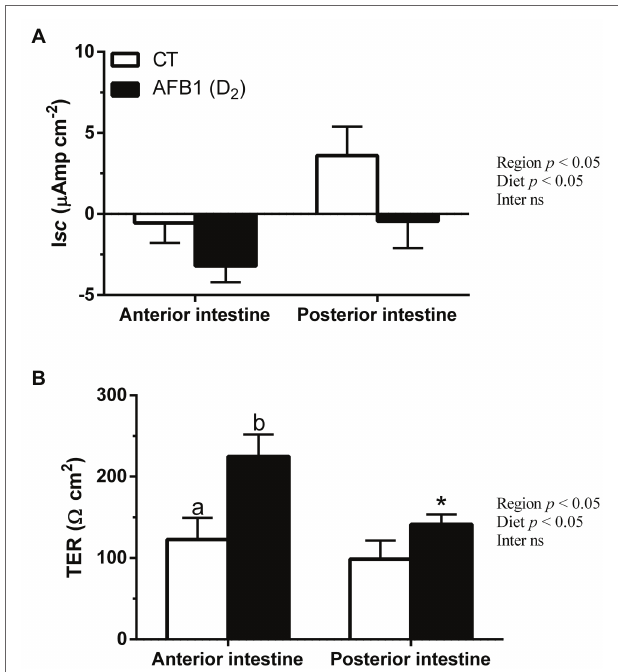
FIGURE 3 | I sc (A) and TER (B) in anterior (AI) and posterior intestine (PI) of S. aurata juveniles fed with different experimental diets (CT, control; and D 2 , 2-mg AFB1 kg − 1 fish feed) for 85 days. Data are presented as mean ± SEM (n = 8–11). For a given intestinal region, different letters indicate significant differences between experimental diets. Asterisks (*) indicate the significance level between different intestinal regions within the same experimental diet. Abbreviation “Inter ns”: interaction not significant ( p < 0.05, two-way ANOVA followed by Tukey’s post hoc